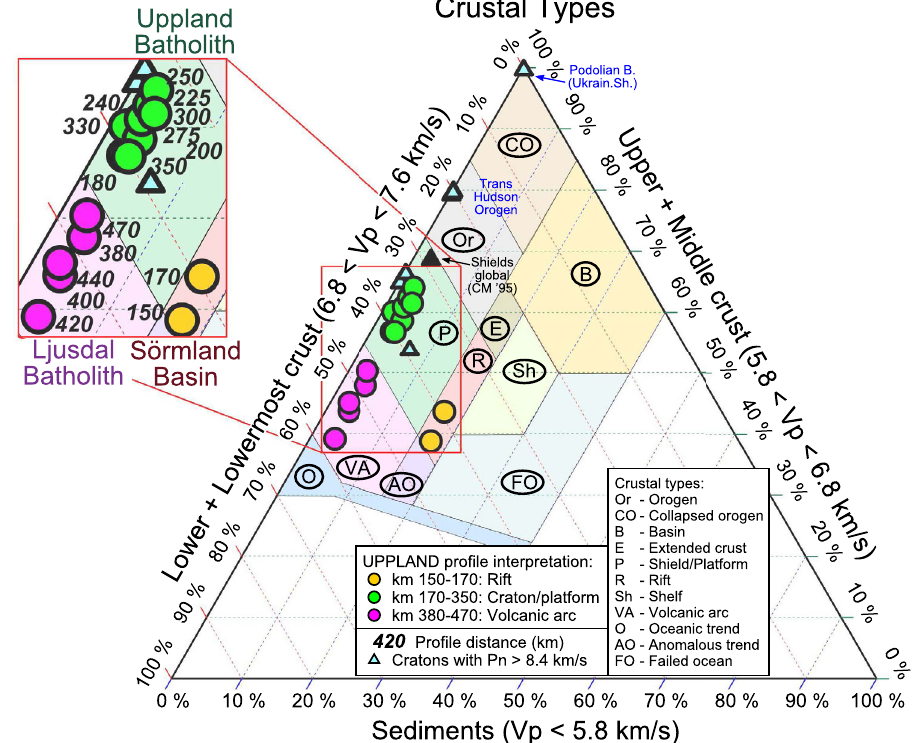
Fig. 9 Ternary plot of the fractions of the metasedimentary, felsic-intermediate and ma fi c crustal layers in the total crustal column. Coloured circles — crustal structure based on our seismic model (Fig. 2) sampled along the pro fi le (orange — Sörmland Basin, green — Uppland Batholith, magenta — Ljusdal Batholith; pro fi le distance in km is marked in the zoomed insert). Blue triangles — cratons globally with Pn > 8.4 km/s (Fig. 3); black triangle — global average for shields and platforms 11 . Background colours with text labels mark typical tectonic domains identi fi ed in a global analysis 61